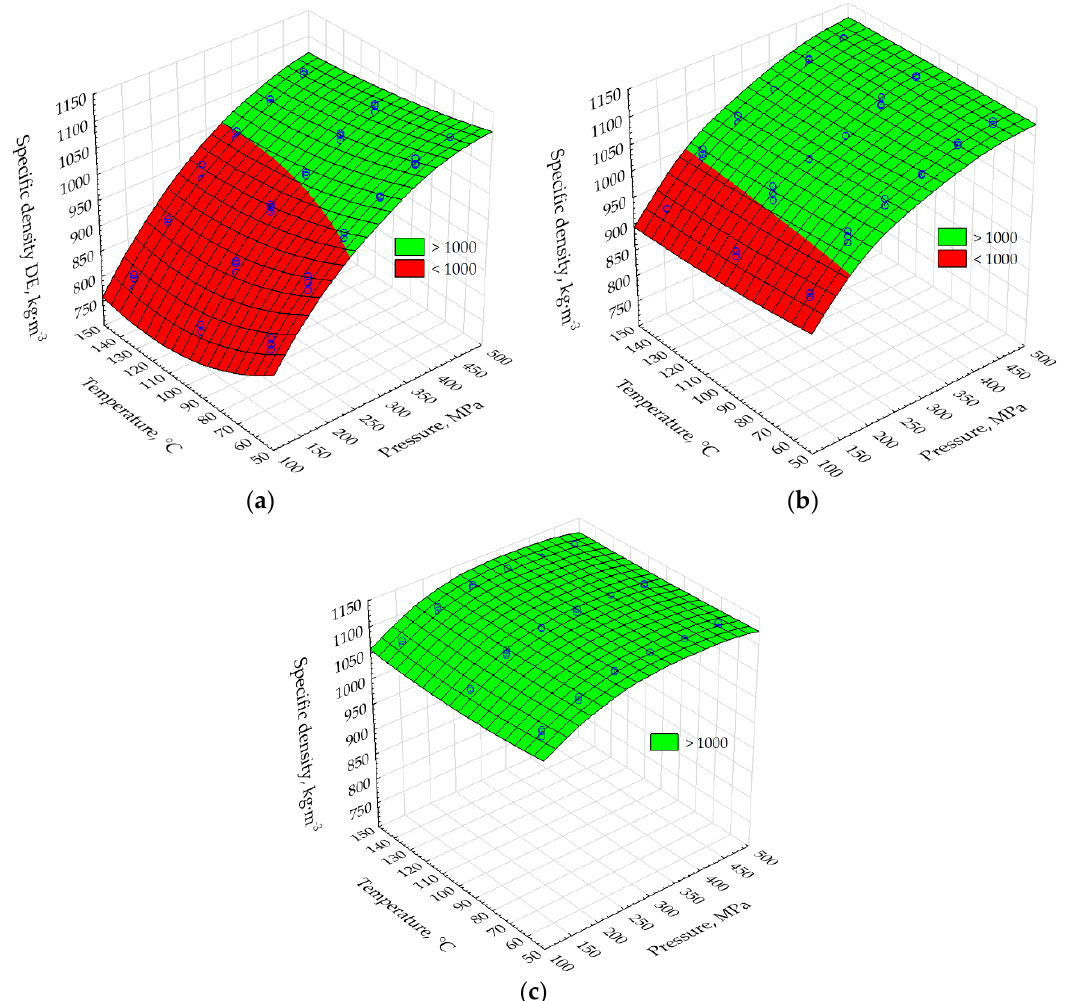
Figure 6. Pellet specific density ( DE ) changes as a function of the raw material drying temperature and densification pressure: ( a ) raw material in the dry state, ( b ) with 5% moisture content, and ( c ) with 10% moisture content.